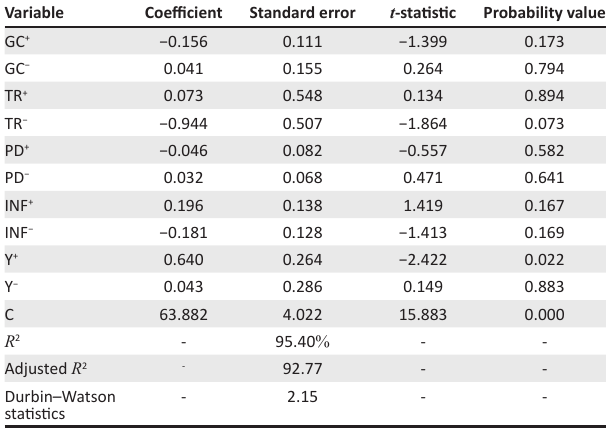
TABLE 3: Long-run results.